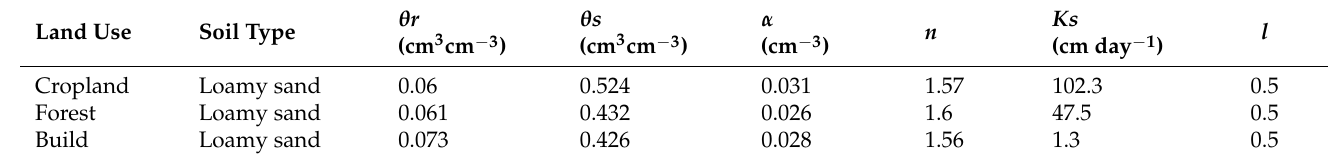
Table 2. The van Genuchten (1980) soil hydraulic parameters for the loamy sand in the Cele